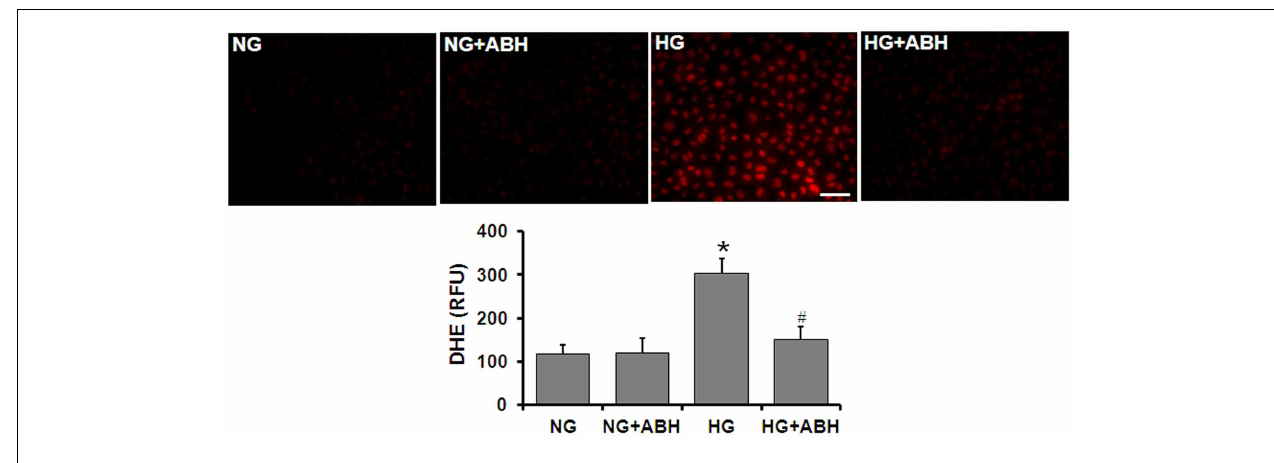
3days. DHE imaging shows a significant increase in superoxide formation in the HG-treated ECs.This effect is markedly blunted by